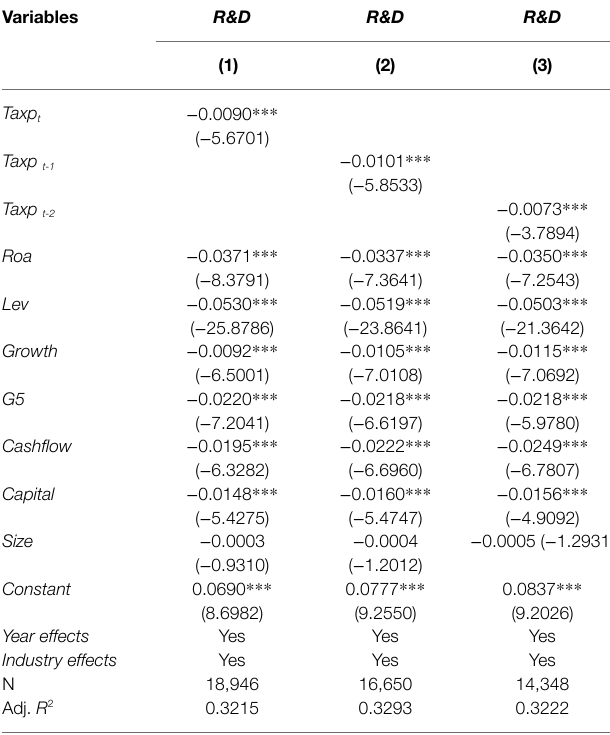
TABLE 3 | Tax incentives and enterprise R&D